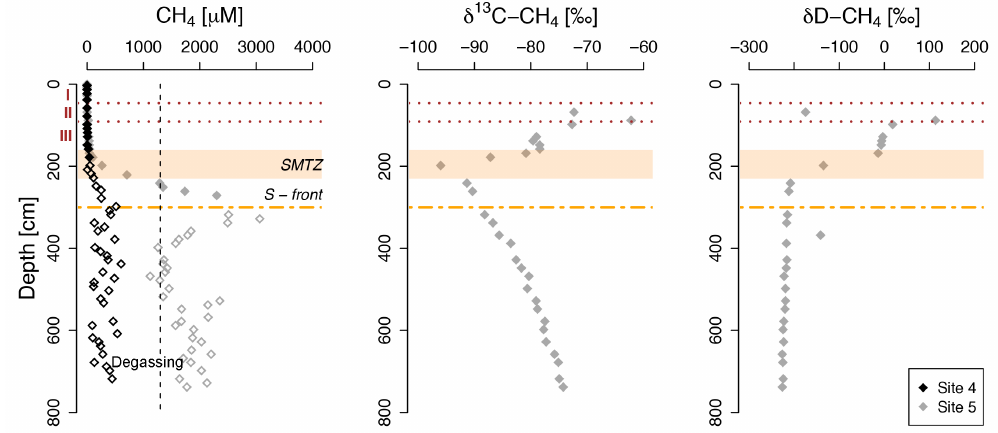
Figure 4. Porewater profiles of CH 4 for site 4 (black diamonds) and 5 (gray diamonds) and corresponding isotopic composition of dissolved CH 4 (available for site 5 only). δ 13 C–CH 4 values are given in ‰ vs. VPDB (Vienna Pee Dee Belemnite), and δ D–CH 4 values are given in ‰ vs. V-SMOW (Vienna Standard Mean Ocean Water). Red dotted lines and roman numbers indicate the transitions between the lithological Unit I (modern coccolith ooze), Unit II (marine sapropel) and Unit III (limnic deposits). The orange bar represents the sulfate-methane transition zone (SMTZ), and the orange dashed line shows the current position of the downward-migrating sulfidization front (S front). The dashed vertical line indicates the CH 4 saturation concentration at atmospheric pressure (Mogollón et al., 2013). The open diamonds indicate CH 4 concentrations that are likely underestimated due to outgassing of CH 4 during